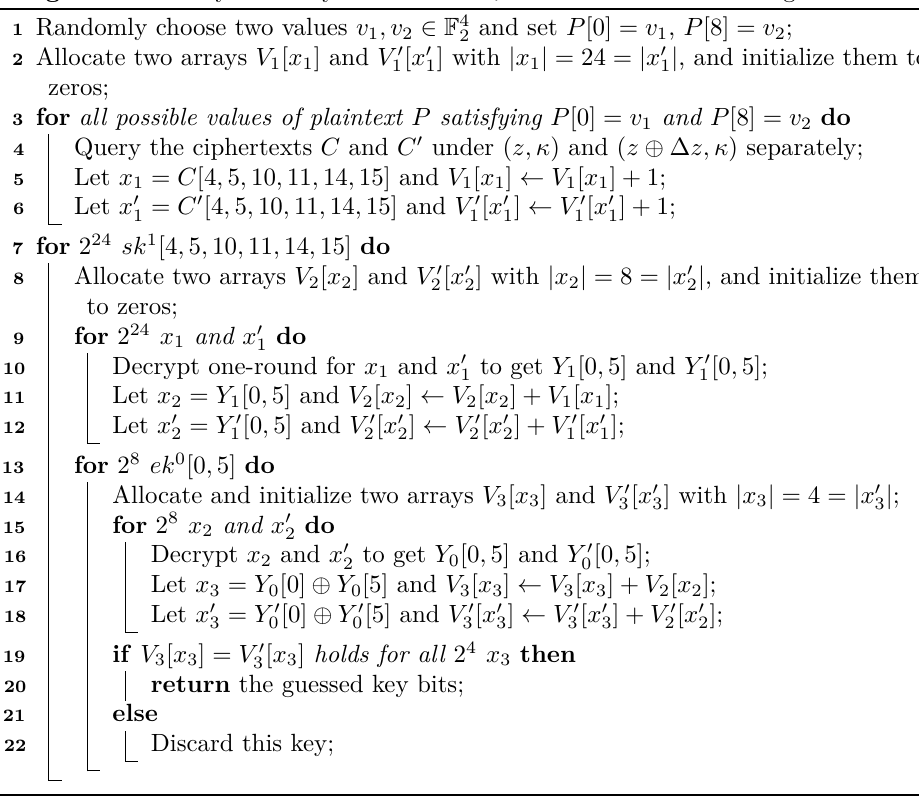
Algorithm 3: Key Recovery of 10-Round QARMA -64 with No. 1